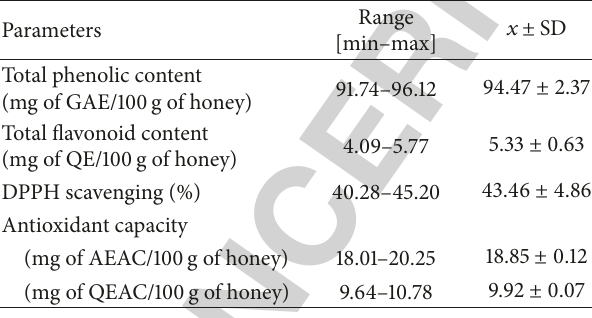
Table 2: Results for total phenolic content, total flavonoid content, DPPH scavenging radical, and antioxidant capacity of strawberry tree ( Arbutus unedo ) honey